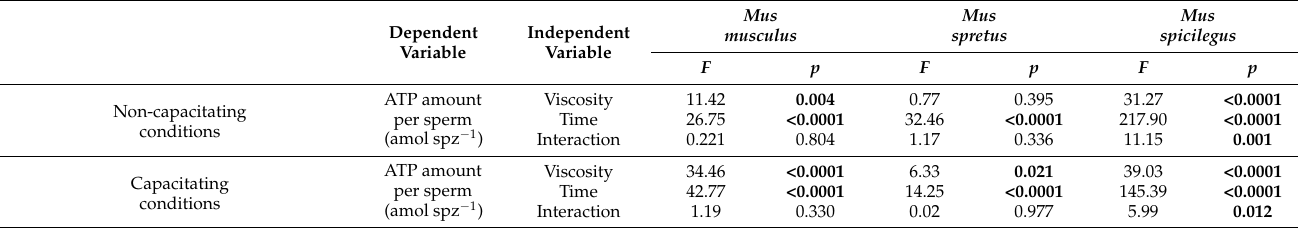
Figure 5. Variation in the amount of ATP per sperm over time. Data are means ± SE ( M. musculus : N = 4; M. spretus : N = 5; M. spicilegus : N = 4). ( A – C ): Amount of ATP per sperm incubated in non-capacitating conditions in low viscosity (mT − H under air) and high viscosity (mT − H + PVP under air). Red squares and letters: non-capacitating conditions in low viscosity (mT − H), and pink triangles and letters: non-capacitating conditions in high viscosity (mT − H + PVP). ( D – F ): Amount of ATP per sperm in capacitating conditions in low viscosity (mT − BH under 5% CO 2 /air) and high viscosity (mT − BH + PVP under 5% CO 2 /air). Dark blue squares and letters: capacitating conditions in low viscosity (mT − BH), and light blue triangles and letters: capacitating conditions in high viscosity (mT-BH + PVP). ( A , D ): M. musculus . ( B , E ): M. spretus . ( C , F ): M. spicilegus . Asterisks indicate significant differences between viscosity treatments for the same time point in a Fisher post-hoc test ( p < 0.05). Different letters indicate significant differences between time points for the same viscosity treatment in a Fisher post-hoc test ( p < 0.05). Table 6. Effect of time and incubation in two non-capacitating treatments (low and high viscosity) and two capacitating conditions (low and high viscosity) on ATP amount per sperm. Values of F and p are the result of repeated measures analyses (ANOVAs). Incubation conditions and time incubation were defined as fixed values, and the individual was defined as a random factor. Results highlighted in bold show significant differences in statistical analysis ( p <